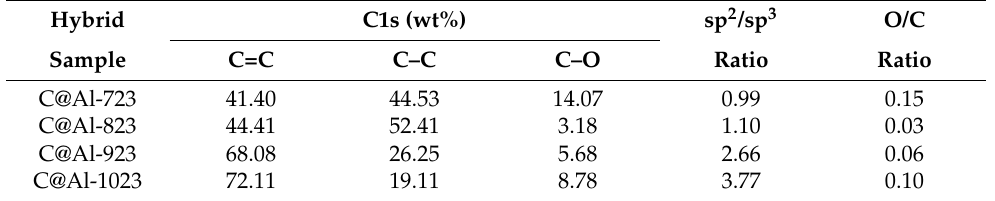
Table 4. Summary of XPS spectra in region C1s for C@Fe–Al 2 O 3 hybrid samples.